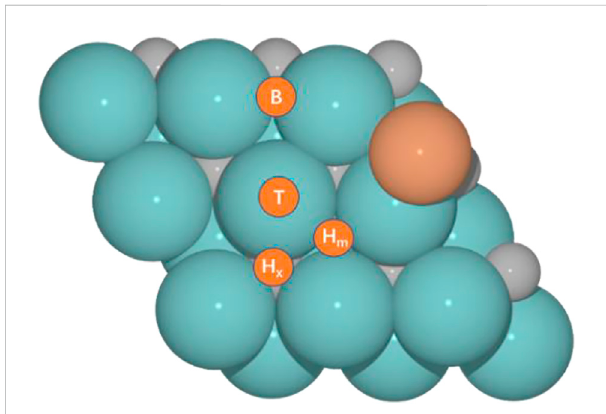
FIGURE 1 Optimized structures for M (Cu and Fe)/Mo 2 C catalytic systems and four adsorption sites, namely, top (T), bridge (B), and hollow sites at X atom (H x ) or metal (H m